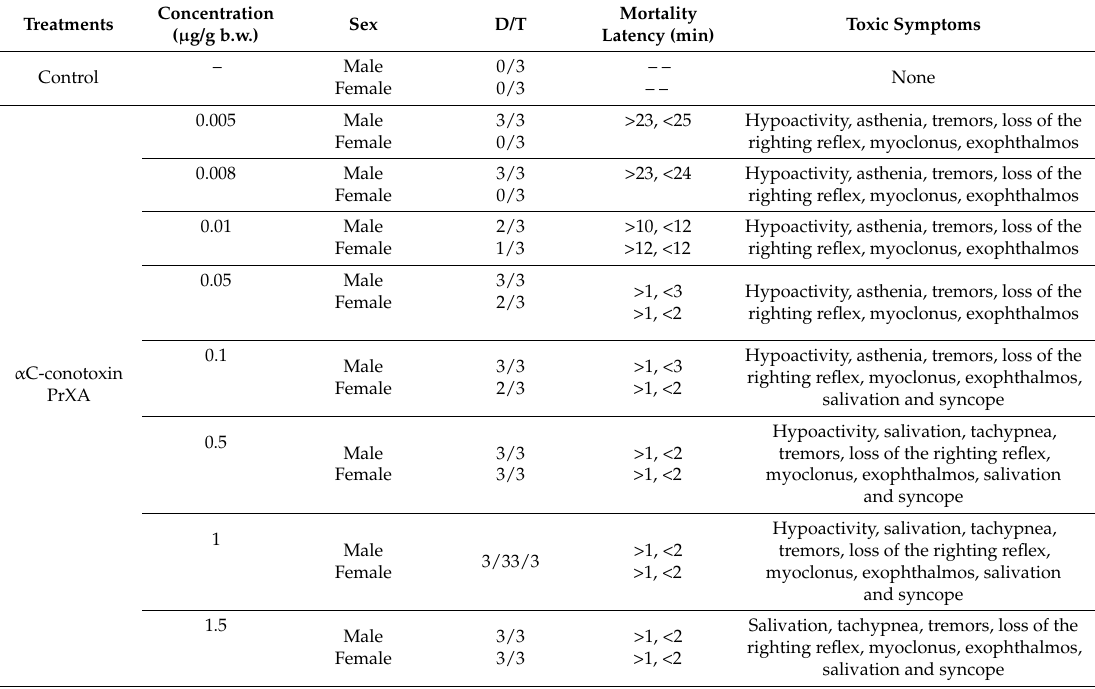
Table 1. Mice phenotypic modifications after intravenous injection of α C-conotoxin PrXA. Concentration Treatments ( µ g/g